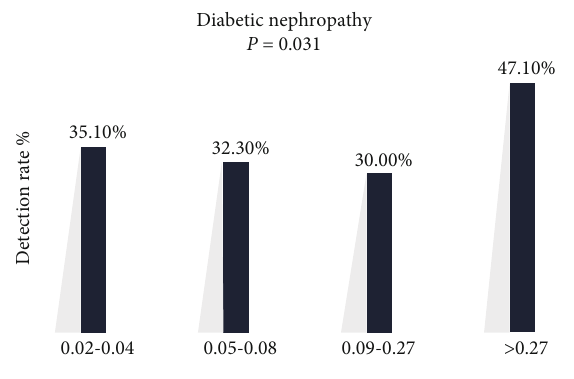
Figure 1: The incidence of diabetic kidney disease in di ff erent KB concentration-based groups: low-normal KB group, 35.10%; middle-normal KB group, 32.30%; high-normal KB group, 30.00%; and slightly elevated KB group, 47.10%; P = 0 : 031 . Table 2: The binary logistic regression analysis of DKD according to KB concentration.